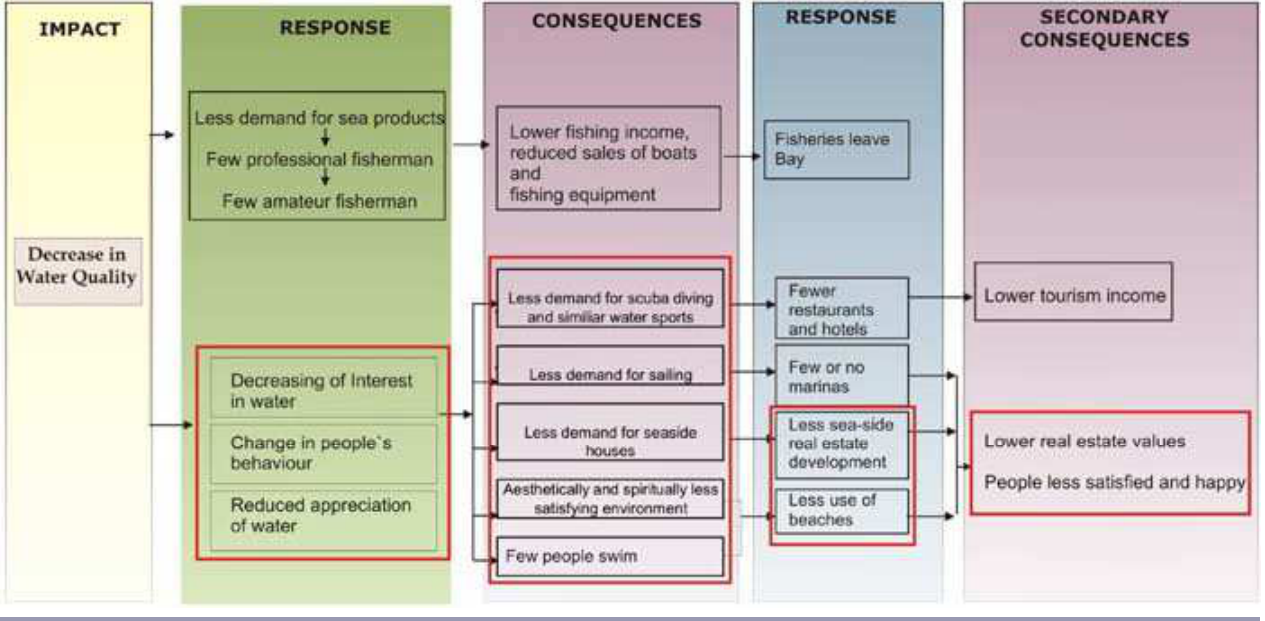
Fig. 6. Impact–response relationship in the Izmit Bay coastal system for the selected PI. Relationships considered by the SSA team are marked by red